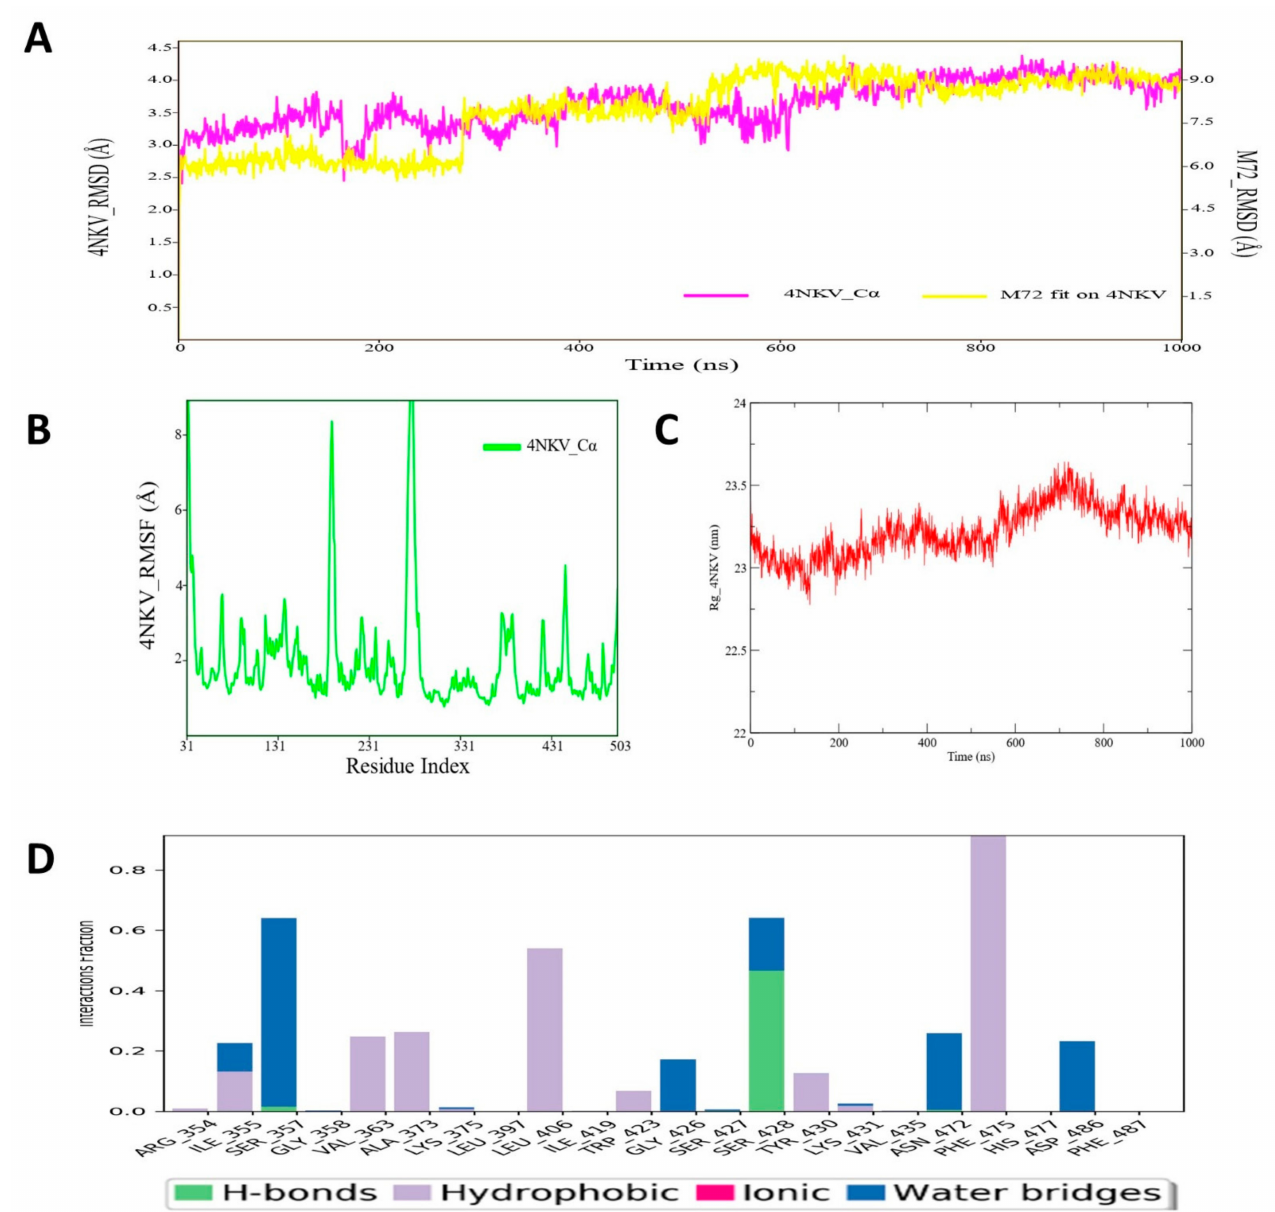
Figure 7. ( A ) RMSD profile of CYP17 (4NKV) protein backbone and compound M72 during 1000 ns simulation; ( B ) RMSF profile of CYP17 (4NKV) protein backbone during 1000 ns simulation; ( C ) RoG profile of CYP17 (4NKV) protein backbone during 1000 ns simulation; ( D ) illustration of the CYP17 (4NKV)–M72 contacts or interactions map monitored during 1000 ns